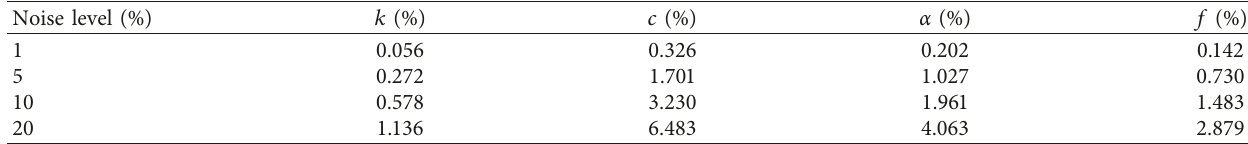
Table 6: Identified errors with different noise levels.